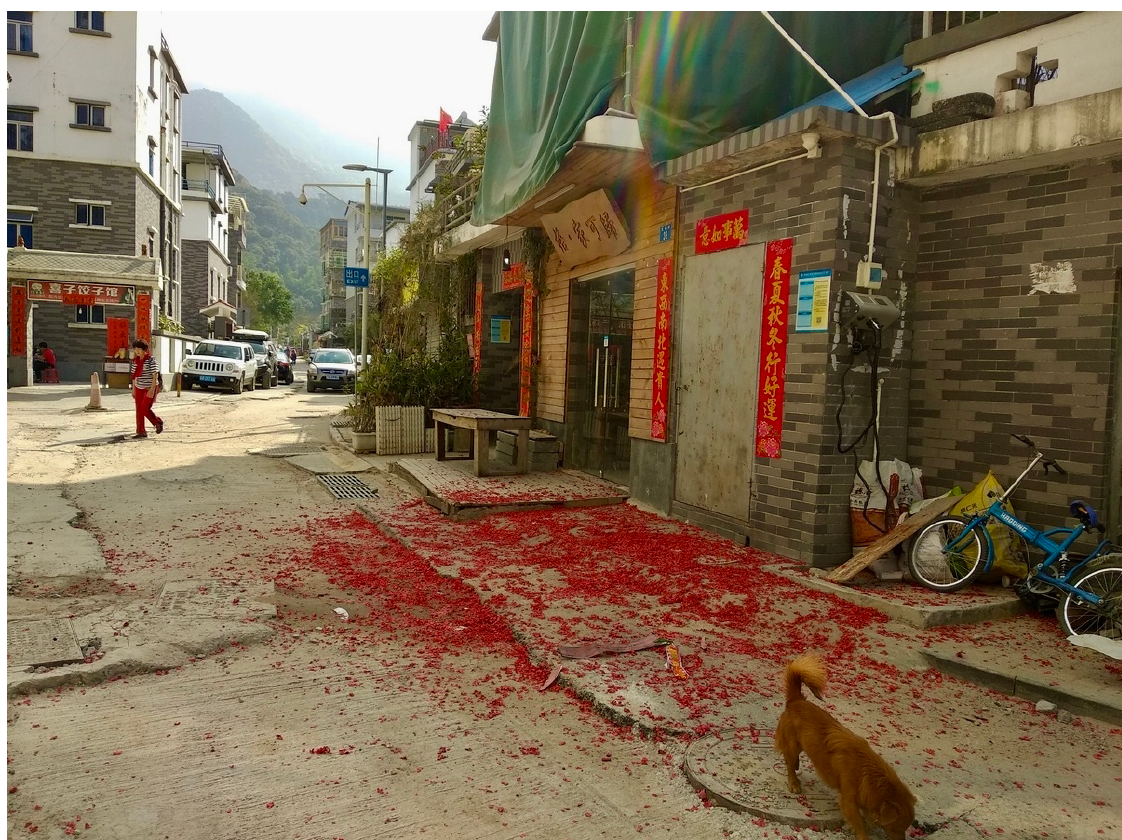
Figure 1 Wutong village